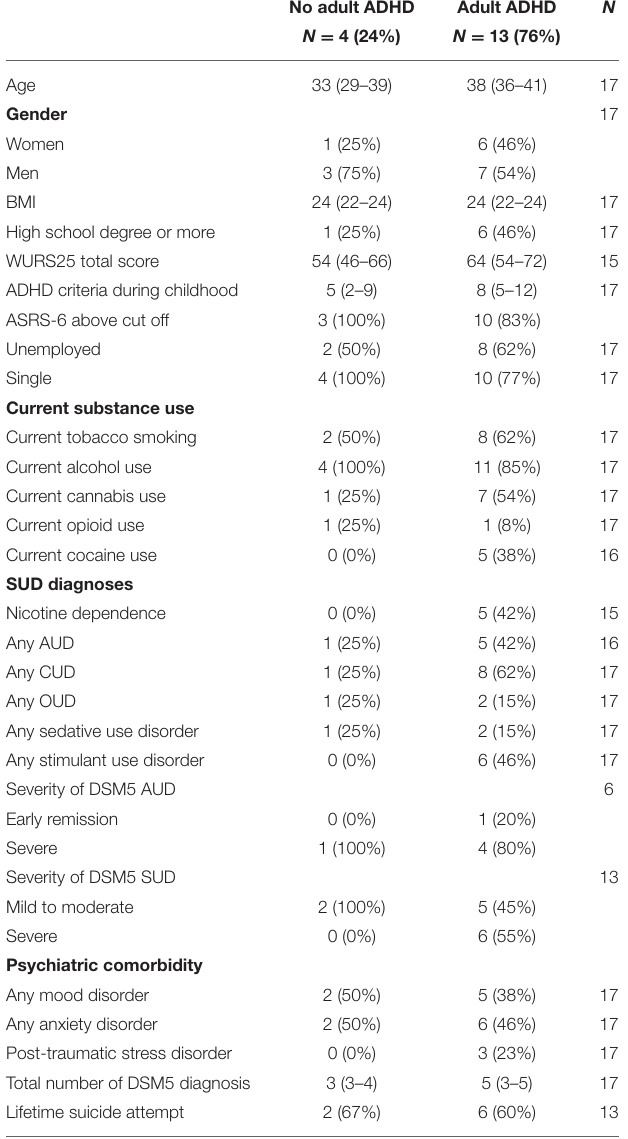
TABLE 2 | Clinical and sociodemographic variables as a function of adult